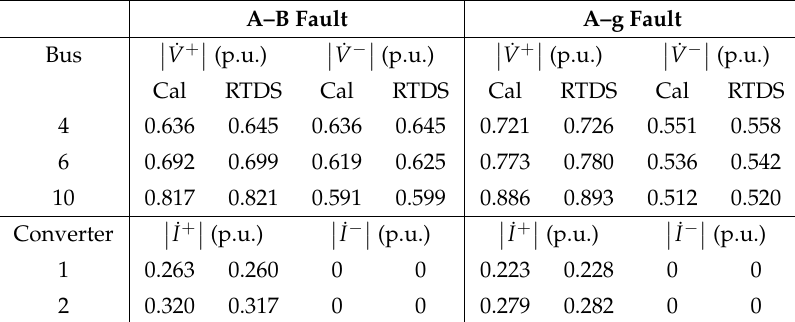
Table 2. Comparison between calculations and simulations (S1).